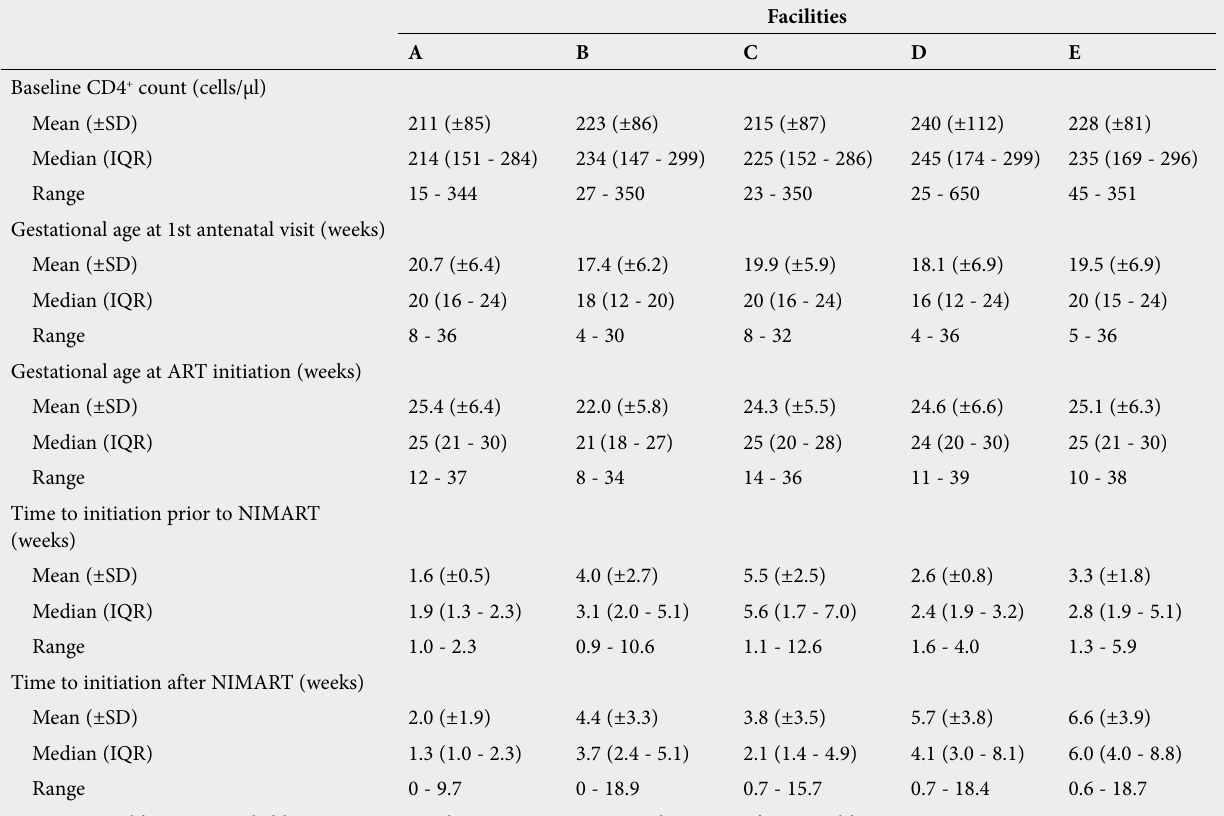
Table 1. Baseline characteristics and timing of ART